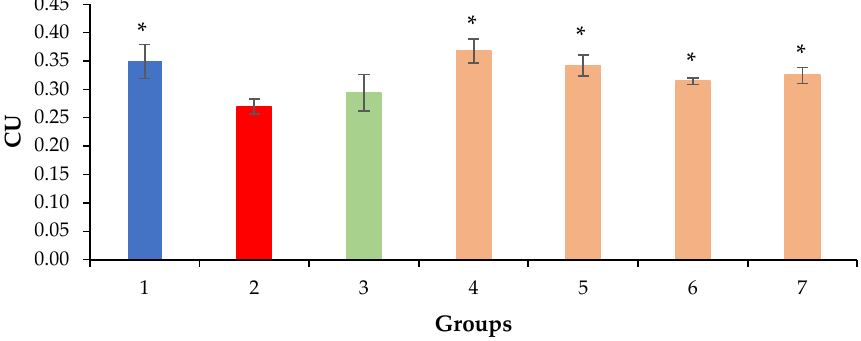
Figure 7. Volume density of liver sinusoids. * p ≤ 0.05 as compared to the negative control. CU: conventional units; 1: intact control; 2: negative control; 3: positive control; 4: mice treated with QS-528 at a dose of 60 mg/kg; 5: mice treated with QS-528 at a dose of 90 mg/kg; 6: mice treated with QS-528 at a dose of 120 mg/kg; 7: mice treated with QS-528 at a dose of 150 mg/kg. A decrease in the volume density of liver necrosis is one of the main indicators of the hepatoprotective effect, which can be observed with the introduction of silymarin at a dose of 100 mg/kg and QS-528 at all doses studied (Figure 8).